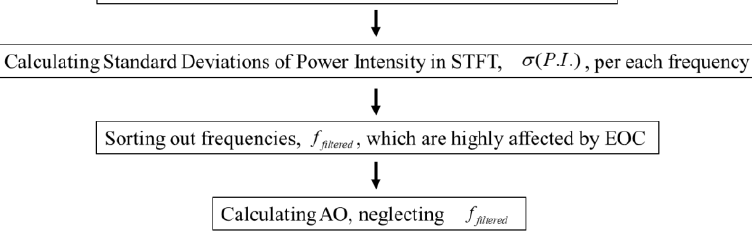
Figure 3. Flow chart for the implementation of the 2nd EOC compensation method.